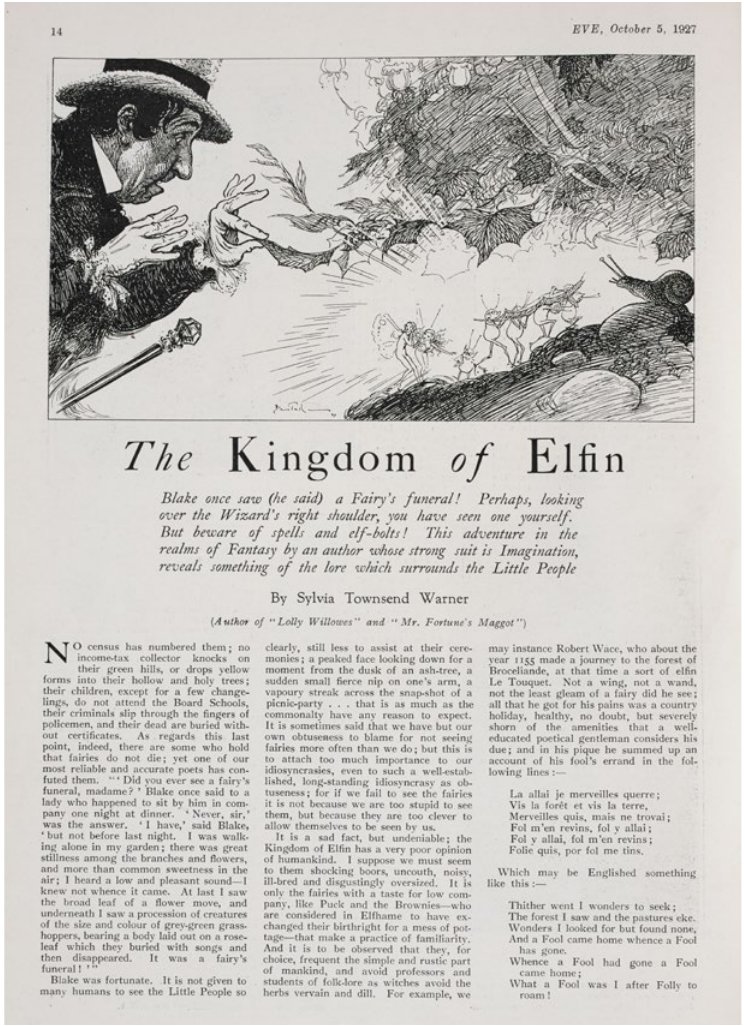
Figure 1.1 The first page of ‘The Kingdom of Elfin’ from Eve , with editorial matter and